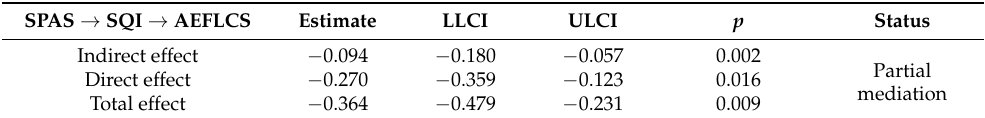
Table 4. Mediation